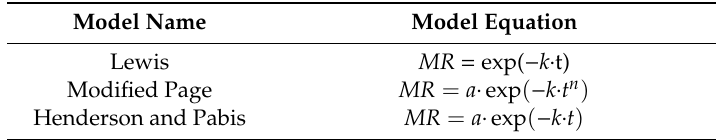
Table 7. Mathematical models applied to drying curves of C. alata